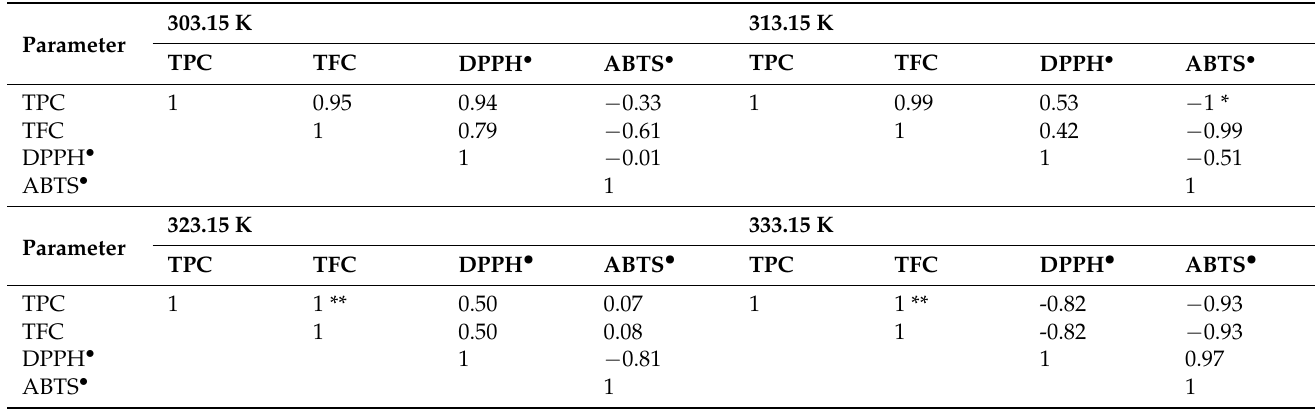
Table 8. Correlation analysis between phenolics, flavonoids, and antioxidant activities of Kyoho skin as affected by drying temperature 1